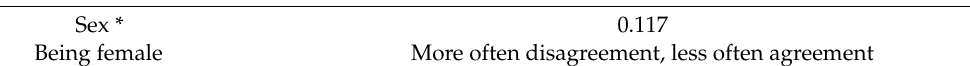
The fattening pigs can live out their natural behaviour